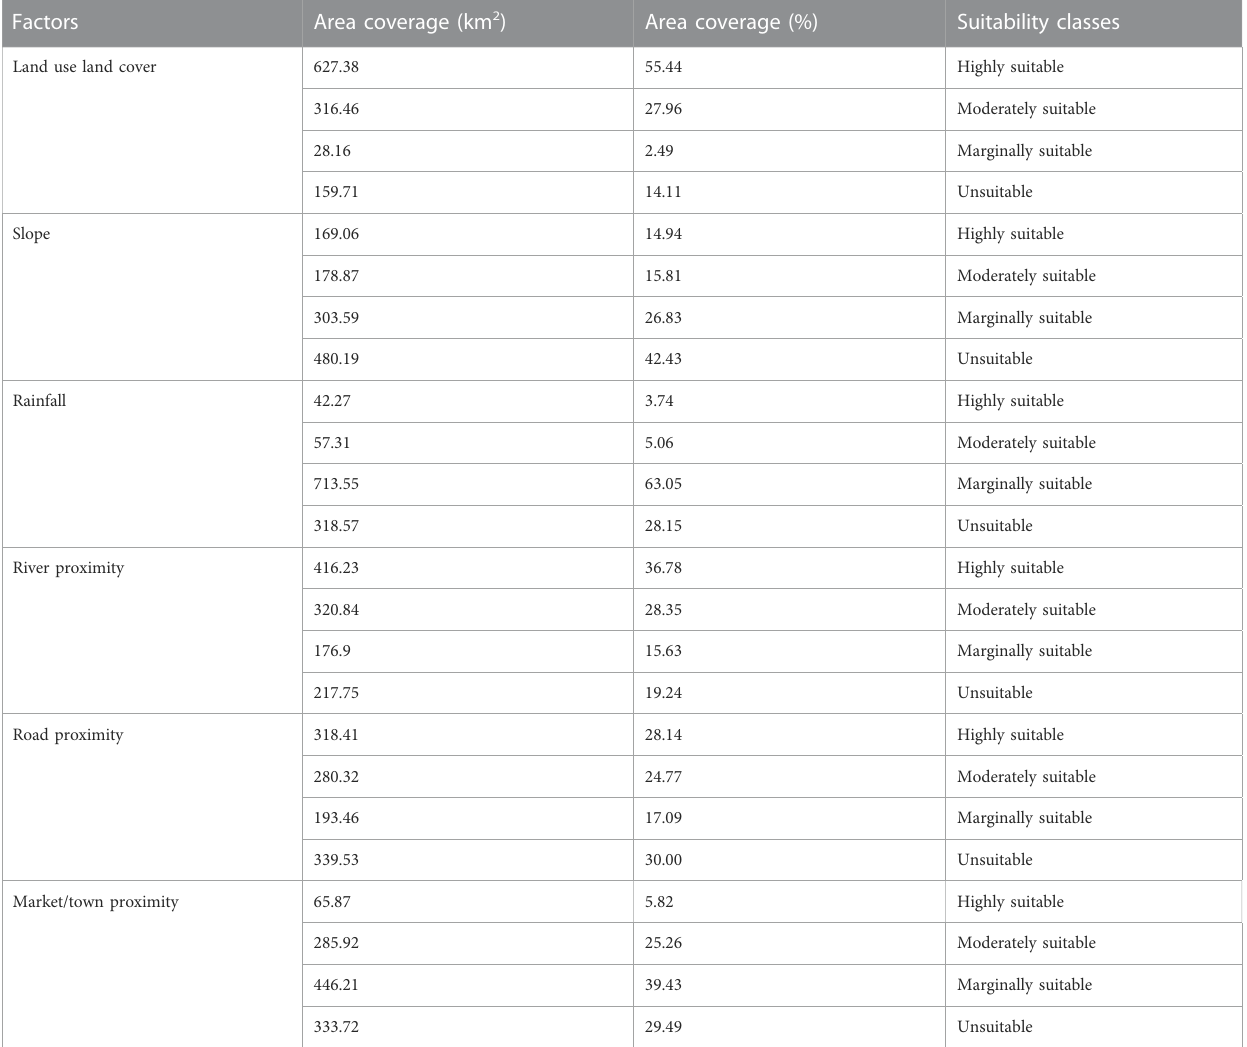
TABLE 5 Suitability analysis of determinant factors for surface irrigation potentials in the Chacha